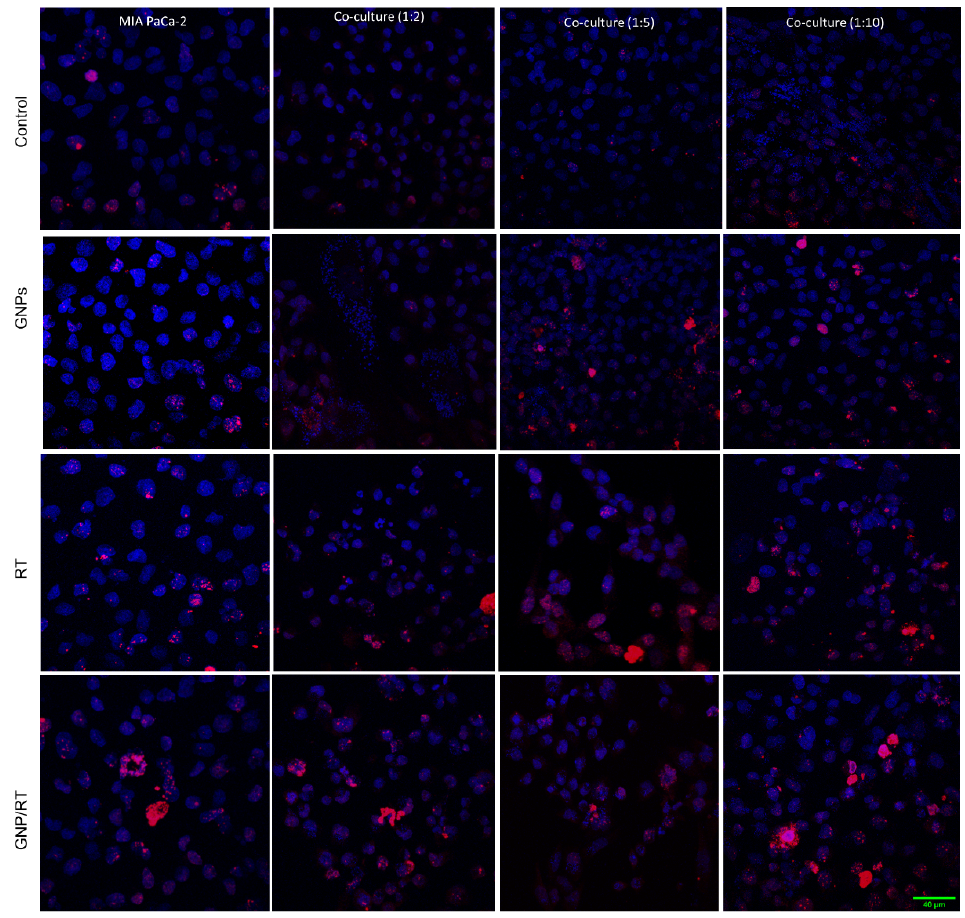
Figure 6. Confocal microscopy images of repair protein γ -H2AX in the nucleus of MIA PaCa-2 and in CAFs. MIA PaCa-2 monoculture (1st column) vs. both MIA PaCa-2 & CAFs co-cultures, 1:2 (2nd column), 1:5 (3rd column), 1:10 (4th column) for control cells (1st row), cells incubated with GNPs (2nd row), irradiated cells (3rd row), irradiated cells with GNP (4th row). Red dots correspond to DNA DSB damages and the blue stains are the cell nuclei. Scale bar is 40 µm.